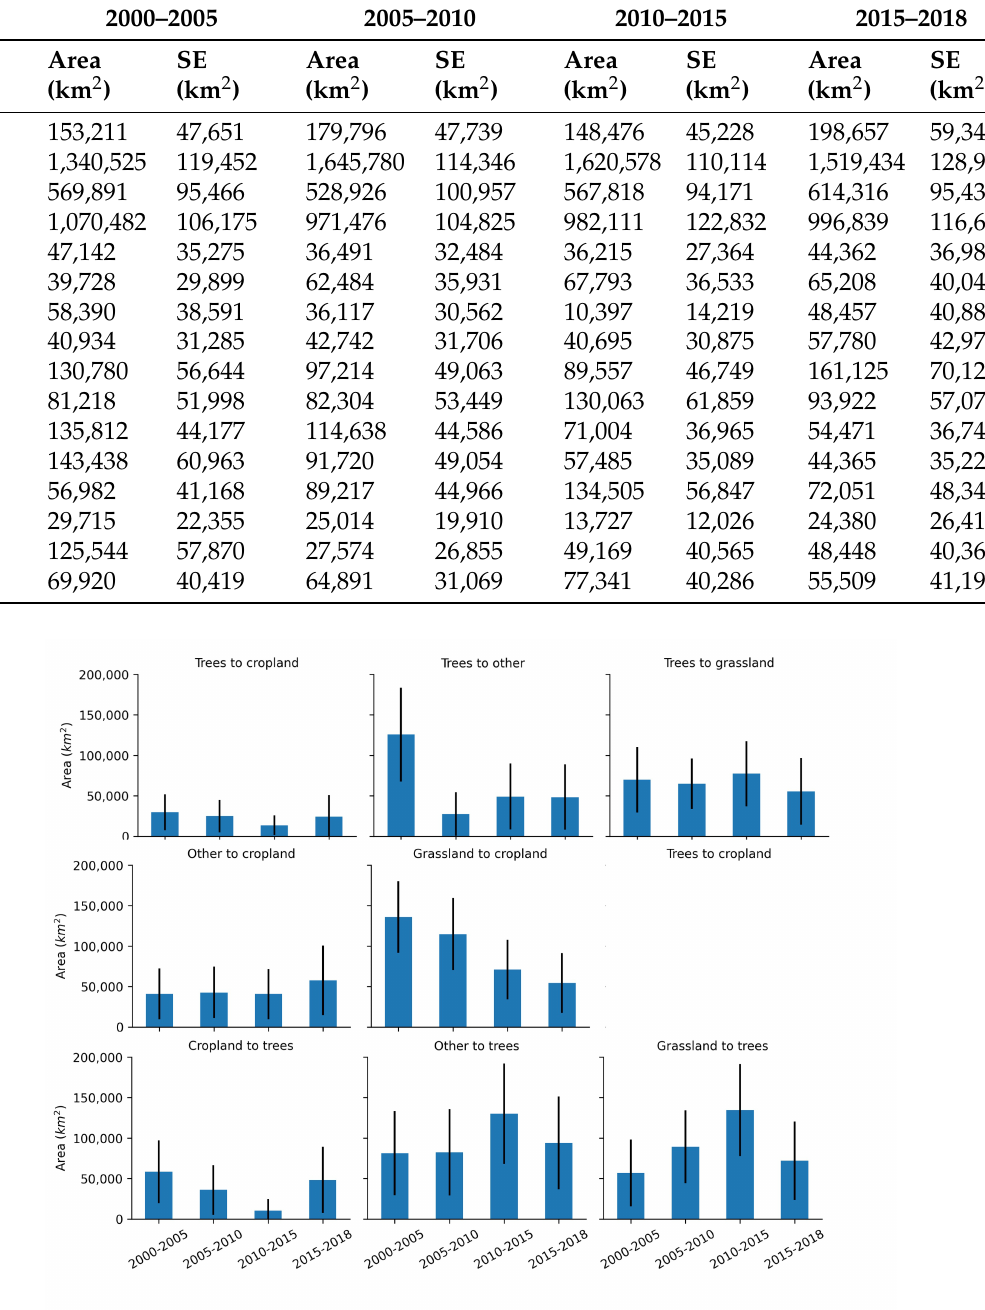
Figure 12. Five-year unbiased area estimates with 95% confidence intervals for change classes estimated from reference data using independent samples for each time